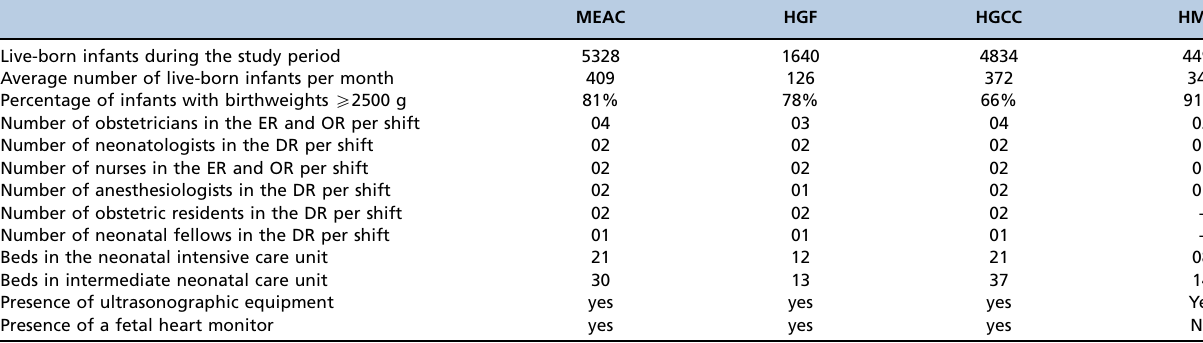
Table 3 - Maternal and neonatal characteristics.